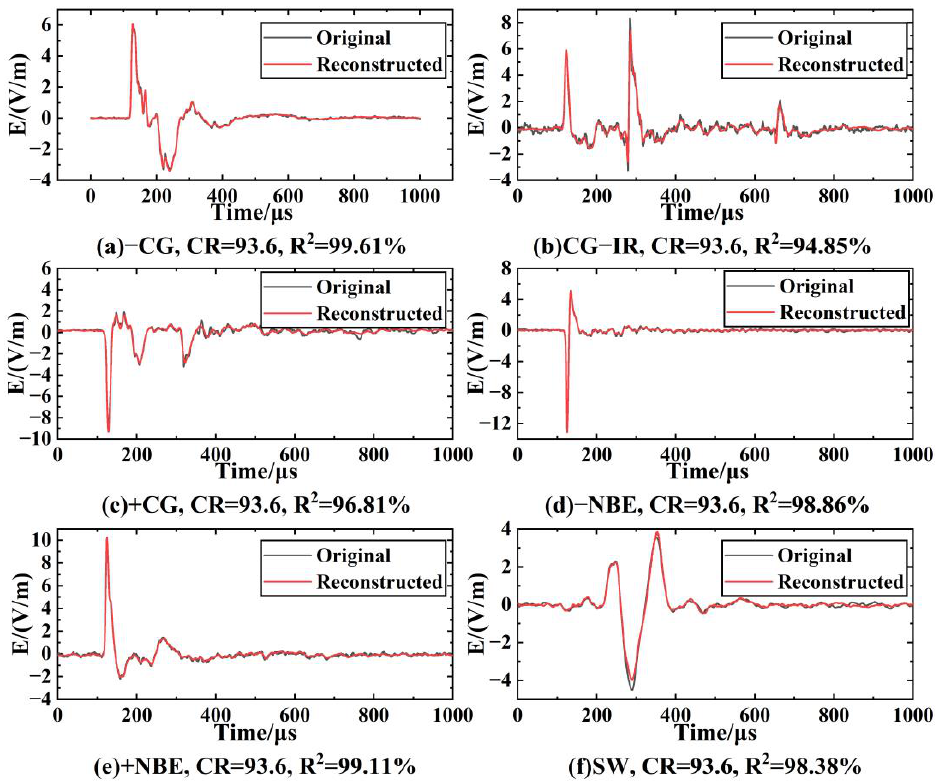
Figure 10. Comparison of original and reconstructed waveforms of LEMP at CR = 93.6%.